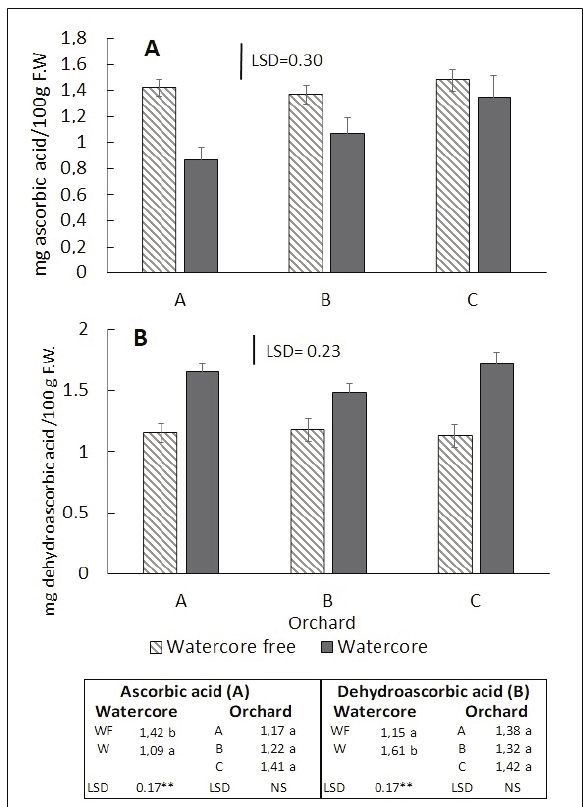
Fig. 5 ­ Ascorbic (A) and dehydroascorbic (B) acid content of watercore­free (WF) and watercore (W) fruit of ‘Pomella Genovese’ apple from three different orchards. Average ± standard error. LSD is reported in each figure (P>0.01). In the box at the bottom the average and LSD values are indicated for each of the main factors (*=P<0.05;